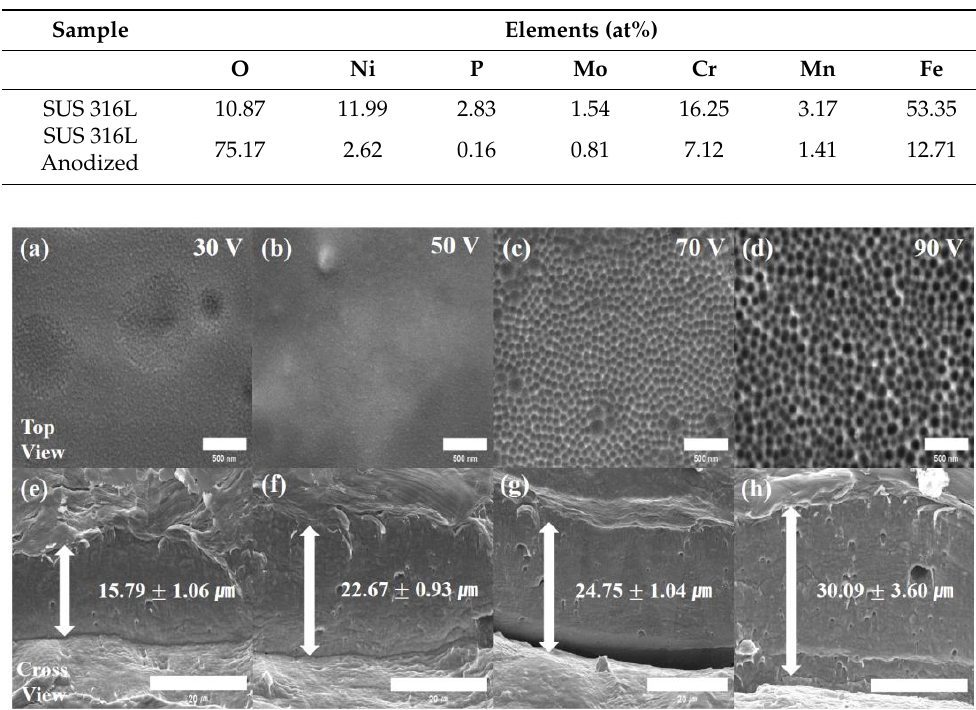
Figure 2. EDS analyses used to compare before and after anodization: ( a ) stainless steel 316L and ( b ) stainless steel 316L after anodization at 90 V. Table 2. EDS analysis data of bare stainless steel and anodized stainless steel 316L.